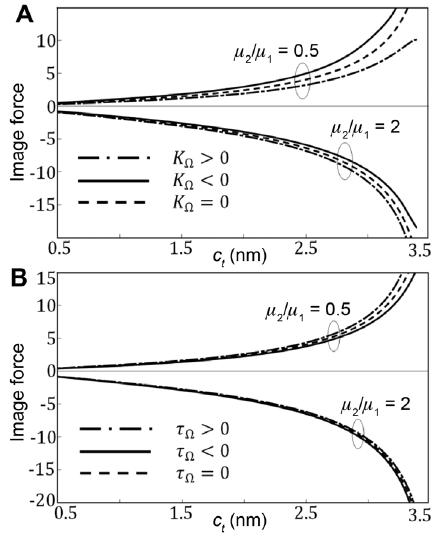
= 0.5 and 2, for a = 4 nm, μ / μ t 2 1 = 0, and (B) different at τ Ω Ω